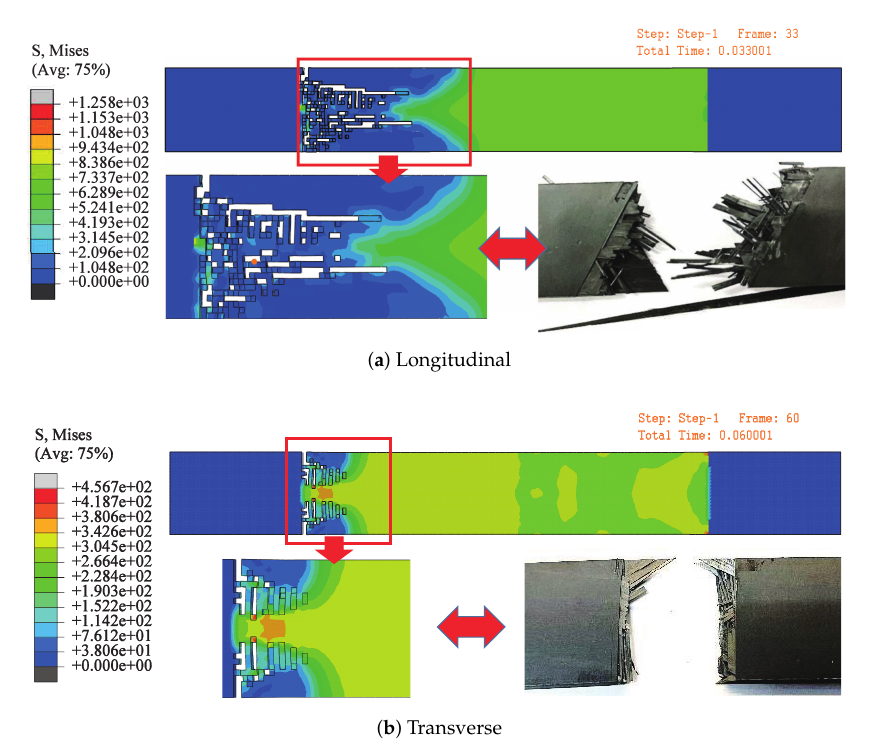
Figure 17. Macro simulation and test of stress and strain.